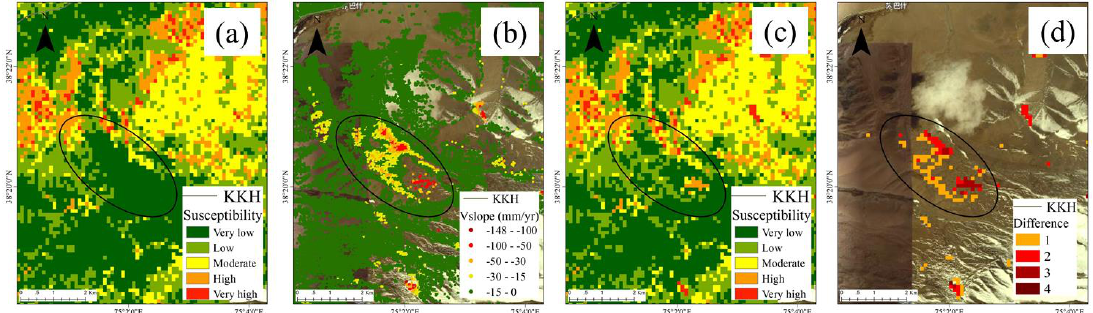
Figure10. Resultsoflandslideassessmentforlocality2(MuztagMountains). ( a )Landslidesusceptibility assessment results obtained by the random forest method. ( b ) SBAS deformation rate values along the slope direction. ( c ) Optimized landslide susceptibility assessment results. ( d ) Mapping results of the di ff erence in the degree of landslide susceptibility assessment before and after